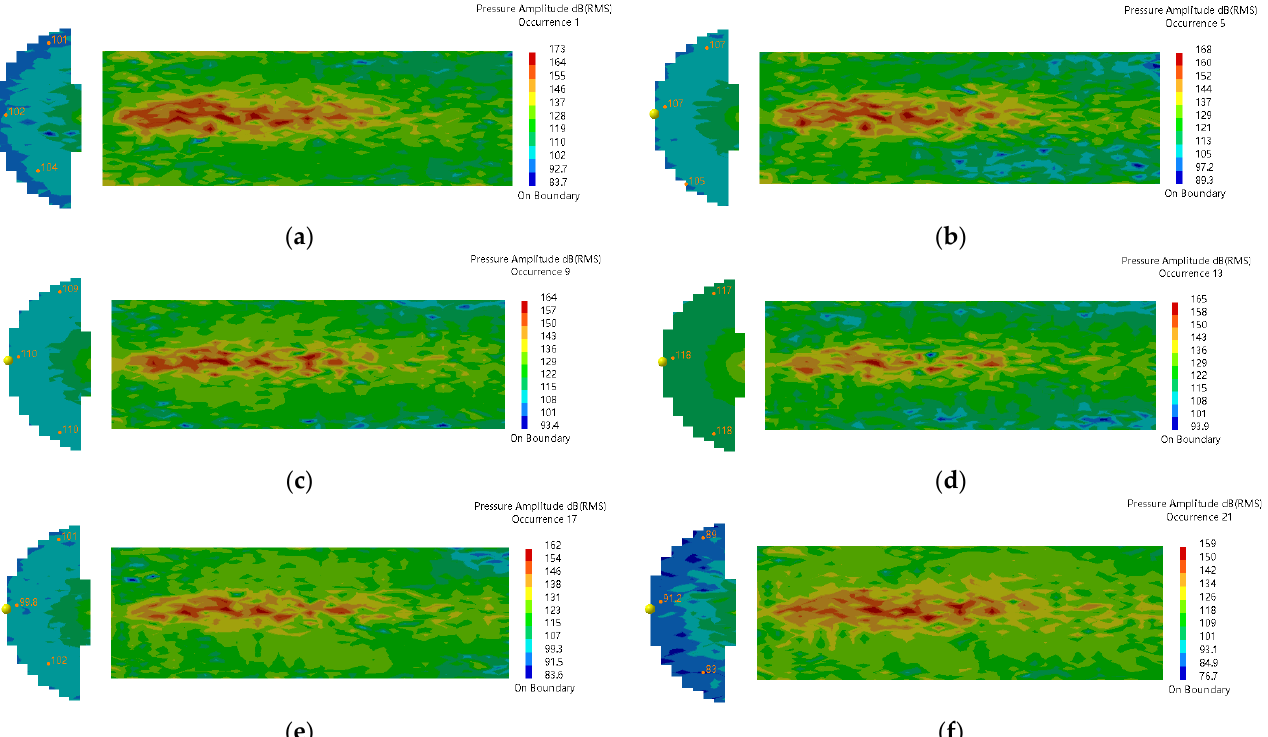
Figure 8. SPL distribution in the sound source zone. ( a ) 20,000 Hz ( b ) 24,000 Hz ( c ) 28,000 Hz ( d ) 32,000 Hz ( e ) 36,000 Hz ( f ) 40,000 Hz.